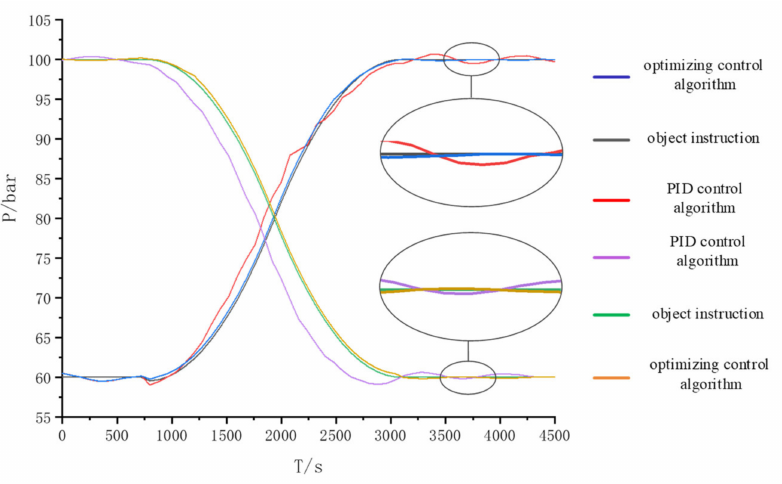
Figure 25. Experimental curve of pressure